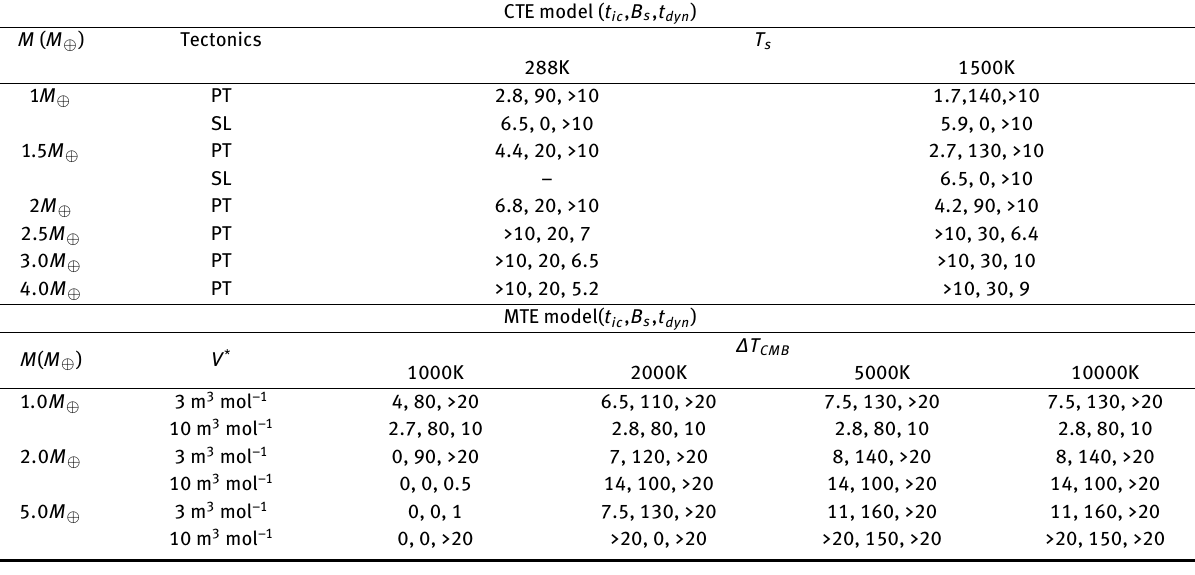
Table 2. Summary of results for the evolution of PMF for CTE (GA10) and MTE (TA11). For every mass and each pair of independent planetary properties (tectonics and surface temperature, T in CTE, activation volume, V * and temperature contrast at CMB, ∆T in MTE), there is s CMB the value of three properties of the dynamo and the predicted PMF: t (Gyr) is the time for the starting of the inner core nucleation, B ( t ) s o ic ( µT ) are surface magnetic field at a reference time taken as the present age of the Earth, 4.54 Gyr and t (Gyr) is the lifetime of the dy- dyn namo. In the CTE stagnant lid (SL), as opposed to plate tectonics (PT) configurations, are not able to produce a dynamo for masses larger than 1.5 M and are not included in the ⊕